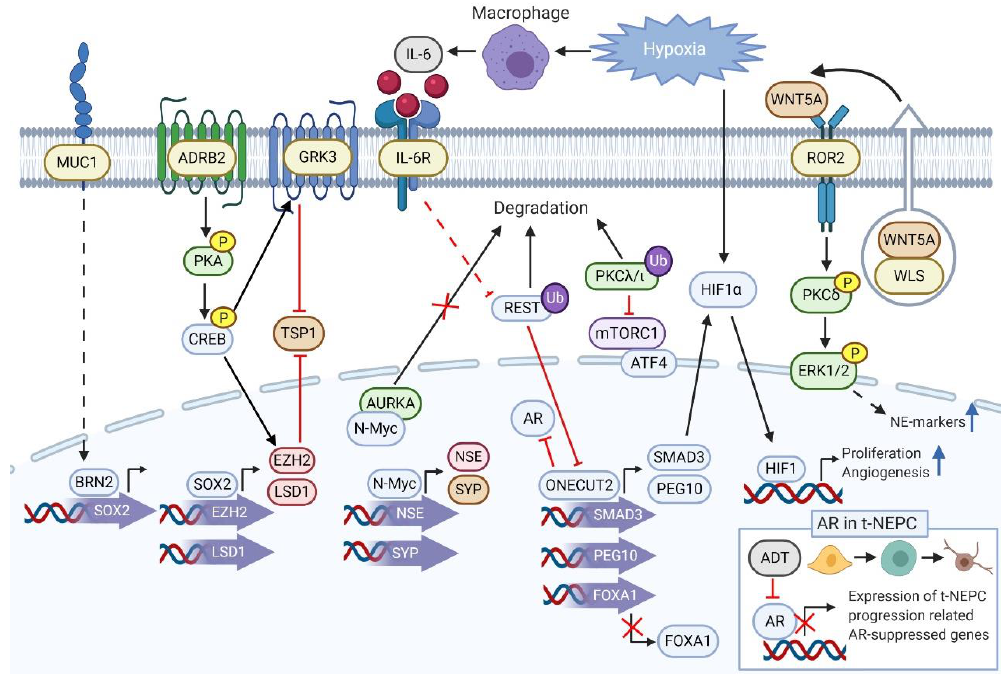
Figure 1. Pathways involved in inducing t-NEPC. BRN2 binds to promoter area of SOX2 increasing its expression. SOX2 in turn promotes expression of epigenetic modulators EZH2 and LSD1 enabling regulation of their NEPC-related target genes. Activation of β -adrenergic receptor, ADRB2 leads to phosphorylation of PKA which phosphorylates and activates CREB. Activated CREB promotes expression of EZH2 and GRK3. GRK3 and EZH2 both have a repressing effect on anti-angiogenic factor TSP1. Increased levels of AURKA are associated with NEPC progression and furthermore AURKA directly interacts with N-Myc preventing its degradation and enhancing expression of N-Myc-regulated neuroendocrine markers NSE and SYP. PKC λ / ι degradation allows mTORC1 complex activation promoting enhanced expression of ATF4-targeted genes involved in t-NEPC progression. Hypoxia also plays a role in prostate cancer progression to its aggressive form. Hypoxia recruits macrophages, which secrete pro-inflammatory cytokine IL-6. IL-6 in turn has on the ability to suppress REST, a negative regulator of genes involved in induction of neuroendocrine differentiation. One of REST targets is ONECUT2, a key driver of NEPC through its ability to promote expression of SMAD3 and PEG10 and to suppress expression of FOXA1. SMAD3 activation allows the modulation of hypoxia related genes through HIF1 α to support proliferation and angiogenesis. WLS assists WNT5A ligand secretion and WNT5A binds to ROR2 receptor. ROR2 phosphorylates PKC, which further phosphorylates ERK1/2. Activated ERK1/2 increases expression of NE markers. AR suppresses expression of several proteins involved in t-NEPC progression while this repressive action is diminished upon androgen deprivation therapy (ADT). Transcription markers are marked as light blue, glycoproteins brown, kinases green, receptors yellow, histone methylases red, promoter regions violet, protein complexes light violet, other factors grey, phosphorylation as a yellow p, and ubiquitylation as a dark violet Ub. Figure was created with